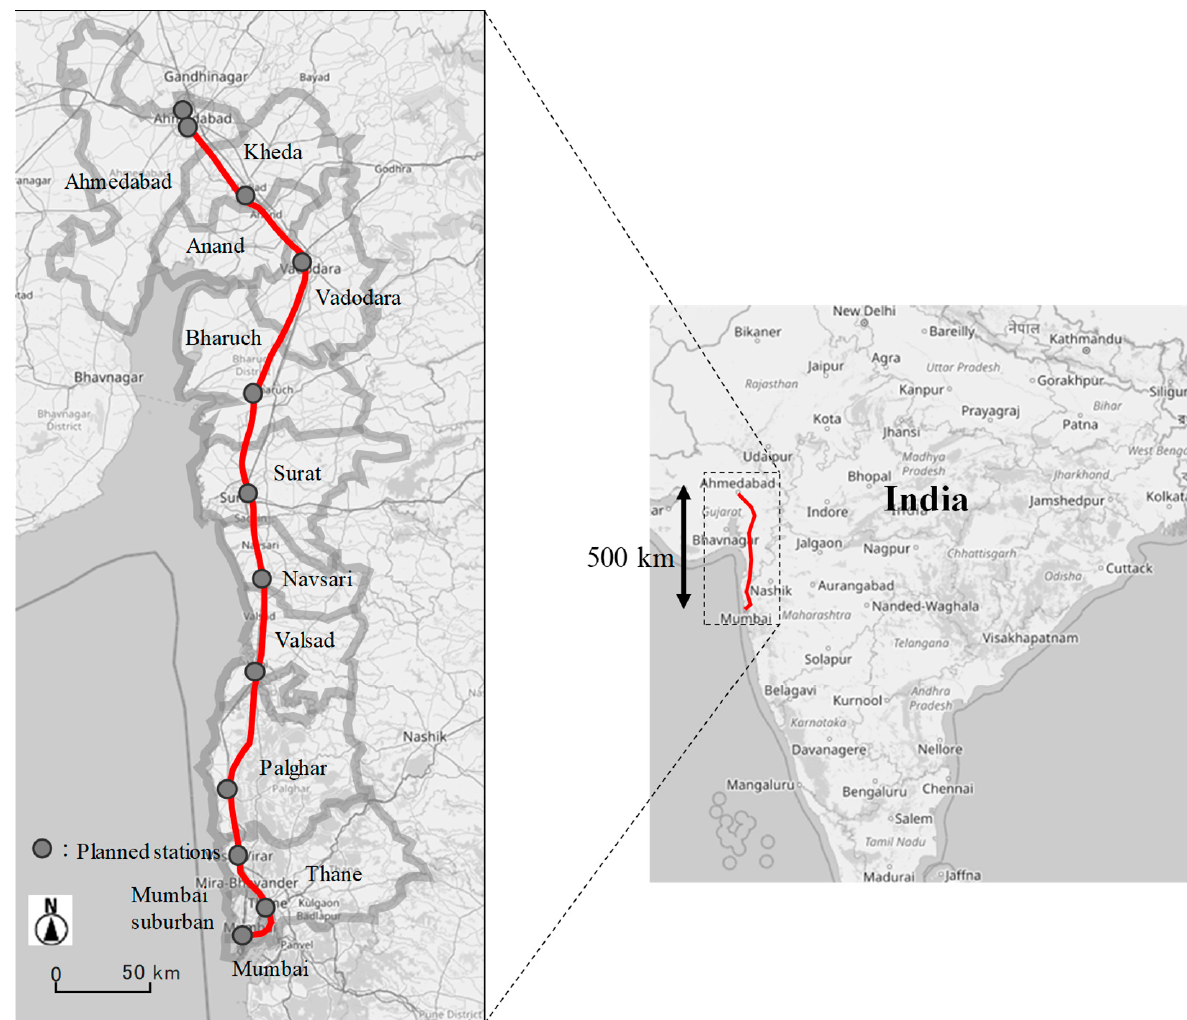
Figure 1. The MAHSR route map (under construction) [7]. Table 1. Overview of the districts along the MAHSR corridor [4].